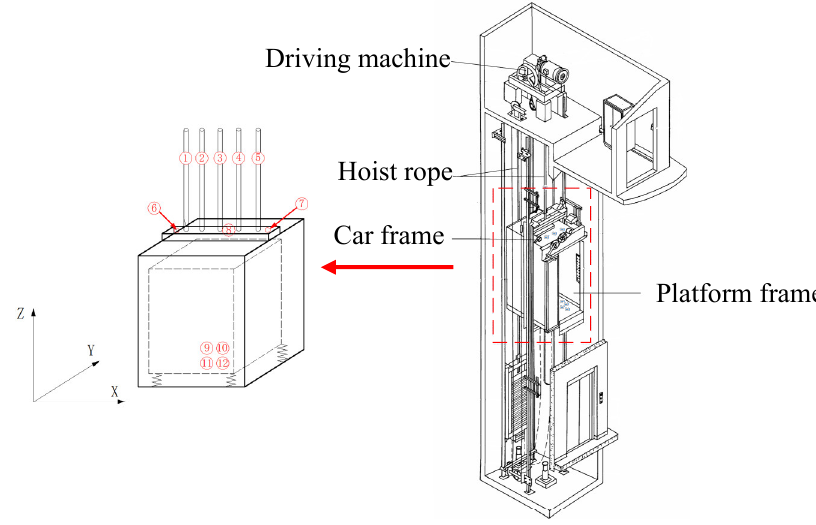
Figure 2. Arrangement and direction of measurement points.